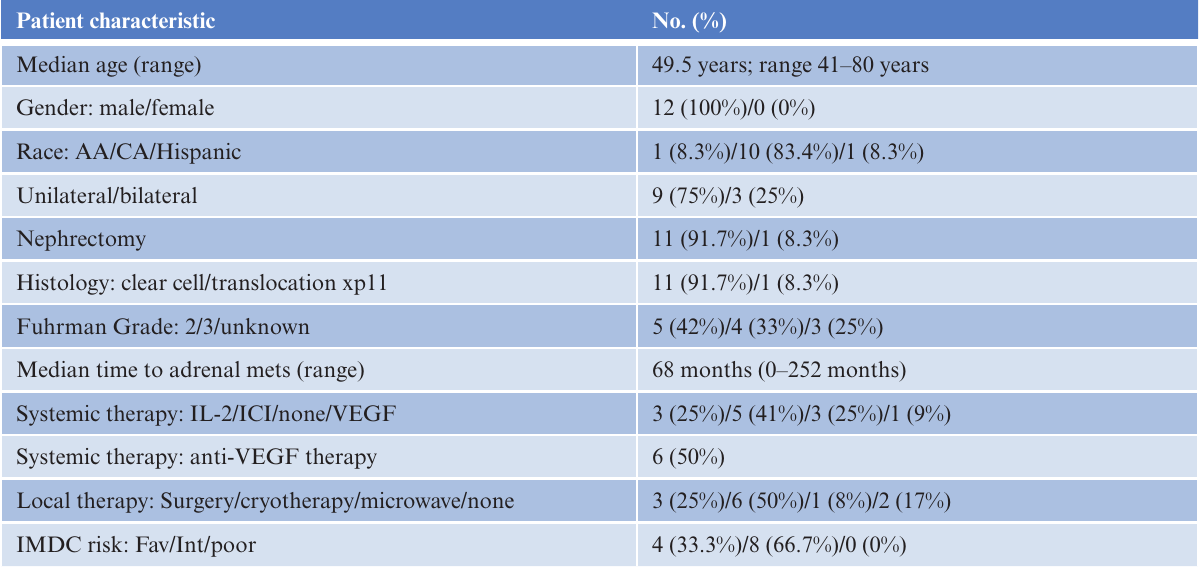
Table 1: Case summaries of advanced renal cancer with adrenal metastases.